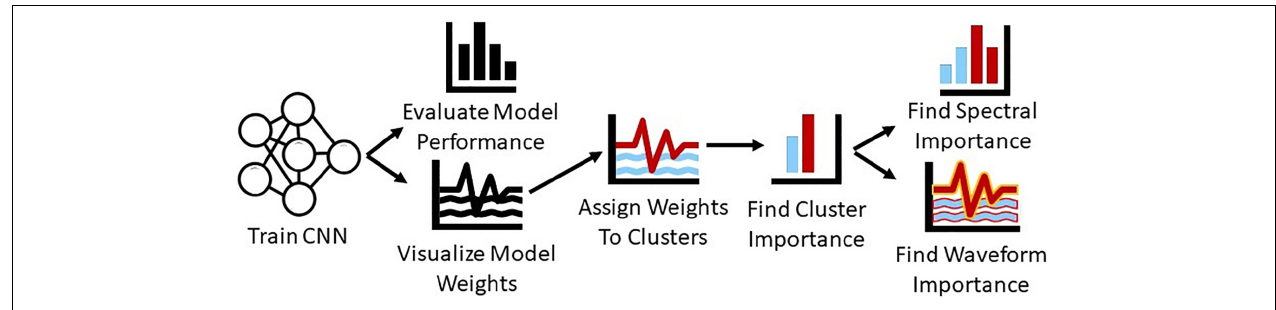
FIGURE 1 | Overview of methods. We train a CNN for sleep stage classification and evaluate its performance. We then visualize the first layer filters of the CNN, convert them to the frequency domain, and cluster them. After clustering the filters, we ablate each cluster to determine its importance and perturb their frequency and time domain representations to determine how much of cluster importance is attributable to the spectra and waveforms within each cluster.